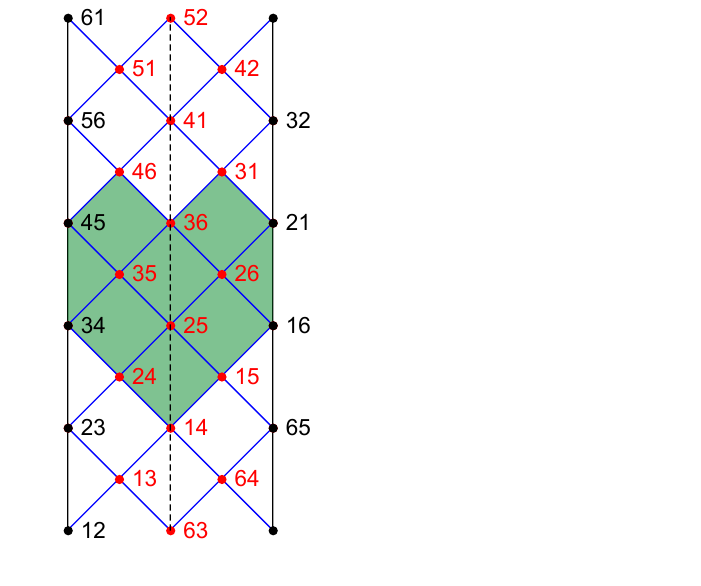
Figure 20 . A region for A 2 n − 3 compatible with central symmetry of the 2 n